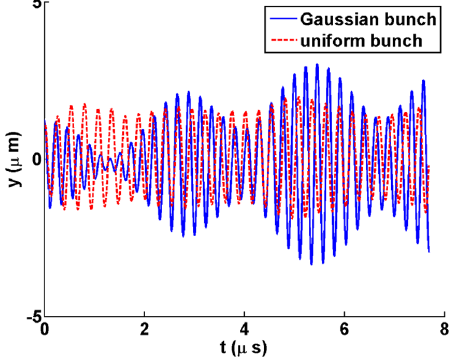
FIG. 2. Vertical oscillation of an ion cloud consisting of H þ 2 ions around the beam potential of a 50 MeV bunch.